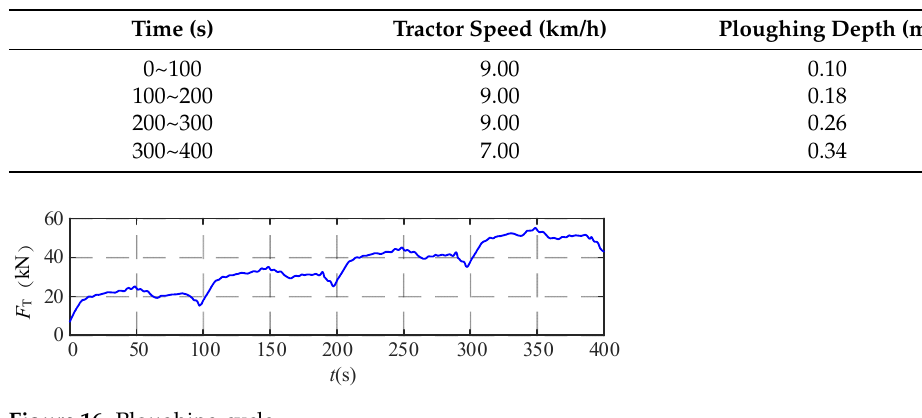
Table 4. Measurement conditions of ploughing resistance.